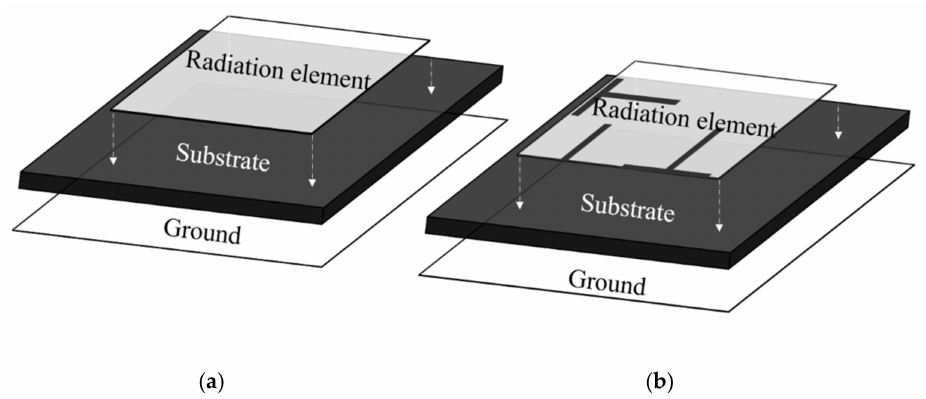
Figure 1. Schematic configuration of ( a ) the unslotted antenna and ( b ) the slotted antenna structures.